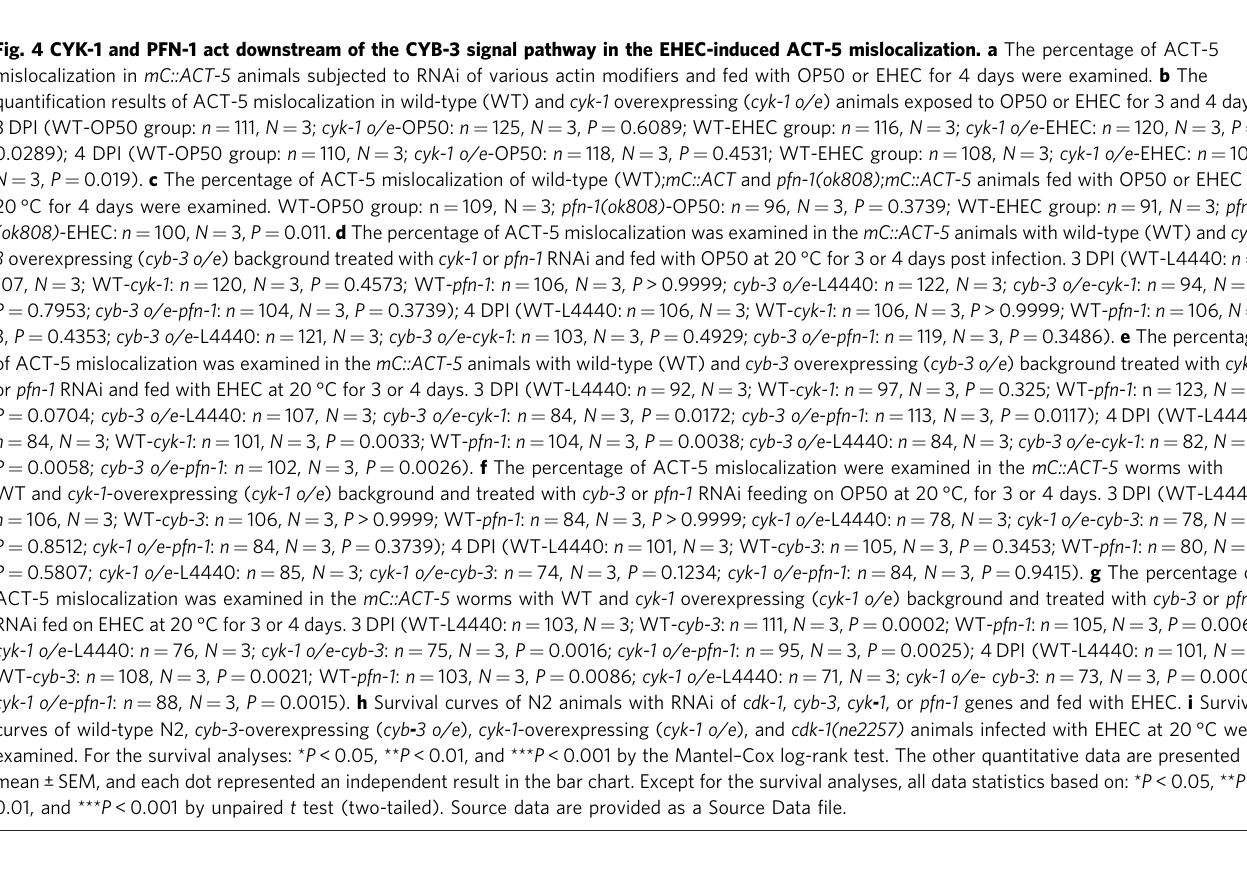
Fig. 4 CYK-1 and PFN-1 act downstream of the CYB-3 signal pathway in the EHEC-induced ACT-5 mislocalization. a The percentage of ACT-5 mislocalization in mC::ACT-5 animals subjected to RNAi of various actin modi fi ers and fed with OP50 or EHEC for 4 days were examined. b The quanti fi cation results of ACT-5 mislocalization in wild-type (WT) and cyk-1 overexpressing ( cyk-1 o/e ) animals exposed to OP50 or EHEC for 3 and 4 days. 3 DPI (WT-OP50 group: n = 111, N = 3; cyk-1 o/e -OP50: n = 125, N = 3, P = 0.6089; WT-EHEC group: n = 116, N = 3; cyk-1 o/e -EHEC: n = 120, N = 3, P = 0.0289); 4 DPI (WT-OP50 group: n = 110, N = 3; cyk-1 o/e -OP50: n = 118, N = 3, P = 0.4531; WT-EHEC group: n = 108, N = 3; cyk-1 o/e -EHEC: n =